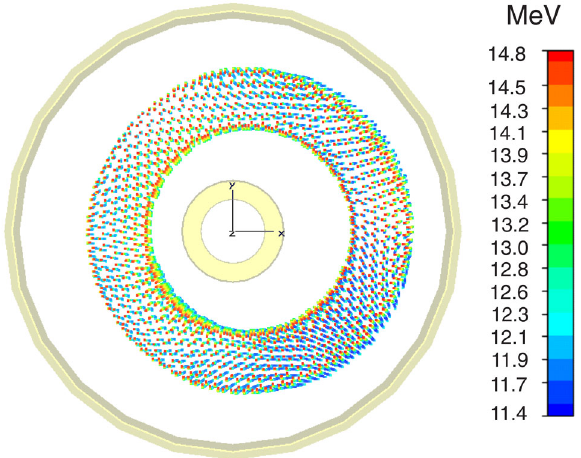
FIG. 23. (Color) The same case as in Fig. 22, but for bunches which are displaced initially by 1 mm to the right from the structure axis.